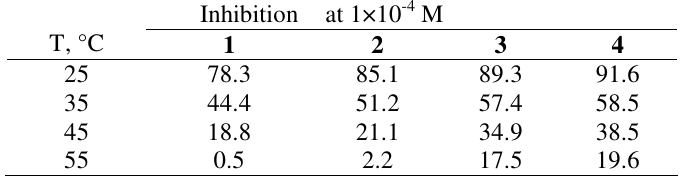
Table 3. Inhibition efficiency (%I) at 1 × 10 -4 M of compounds ( 1- 4 ) for the corrosion